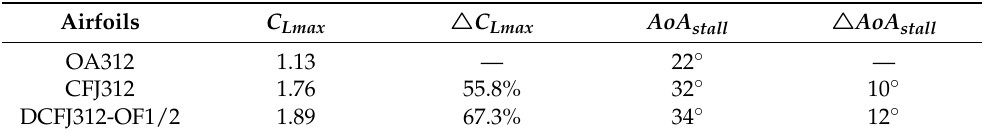
Table 4. Comparisons of maximum lift coefficients and stall AoA s of DCFJ312 and CFJ312 airfoils.